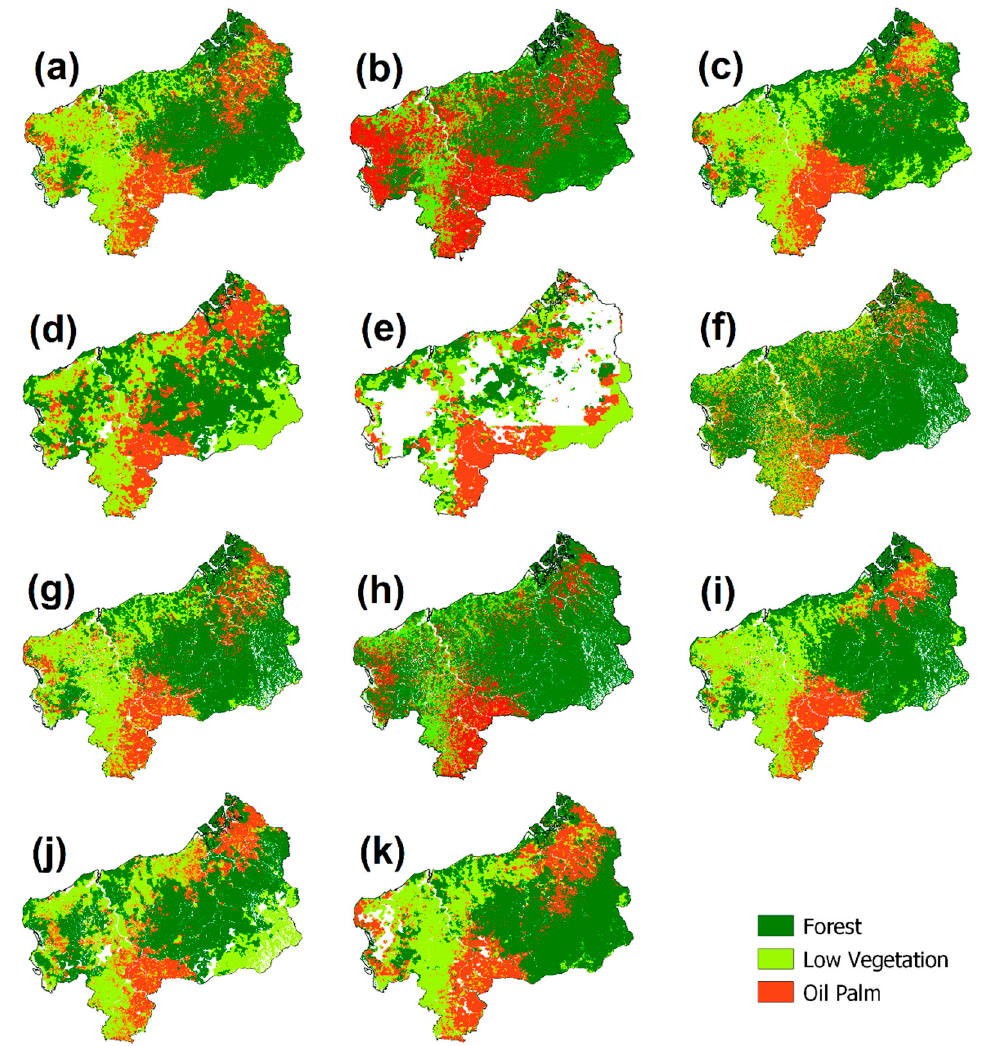
Figure 3. Land-cover maps of the year 2017 based on optical, thermal, and microwave features and data-fusion combinations. ( a ) Vegetation Indices (VIs) map; ( b ) Phenology metrics (PHENO) map; ( c ) Spectral Reflectance Bands (SRBs) map; ( d ) Daytime Surface Temperature (DST) map; ( e ) Nighttime Surface Temperature (NST) map; ( f ) Synthetic Aperture Radar (SAR) map; ( g ) SAR + VI map; ( h ) SAR + PHENO map; ( i ) SAR + SRB map; ( j ) SAR + DST map; and ( k ) VI + DST map.